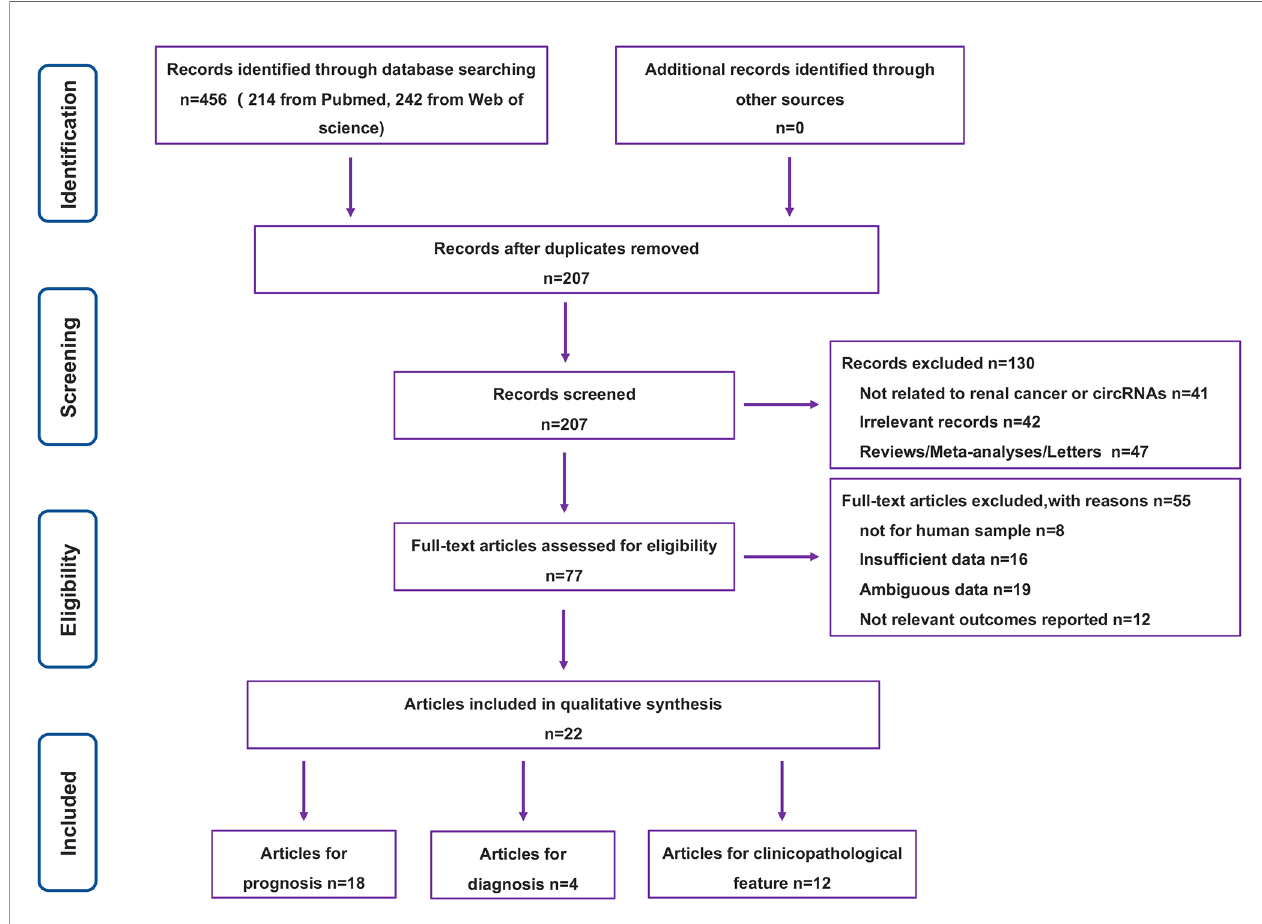
FIGURE 1 | The PRISMA fl owchart of the literature selection